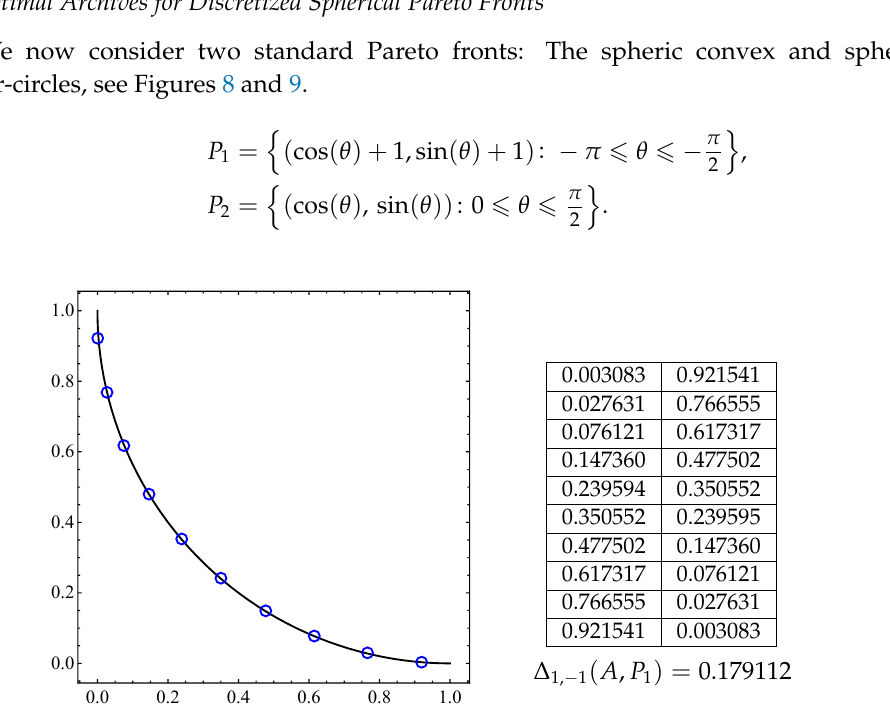
Figure 8. Optimal ∆ 1, − 1 archive A for the connected Pareto front P 1 given by Equation (12) with 10 elements (blue circles) and at the right is the respective archive coordinates and the ∆ 1, − 1 distance.